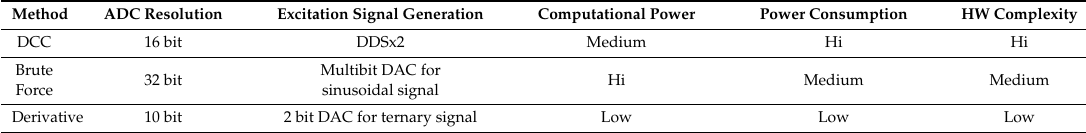
Table 2. Comparison of the three di ff erent acquisition methods